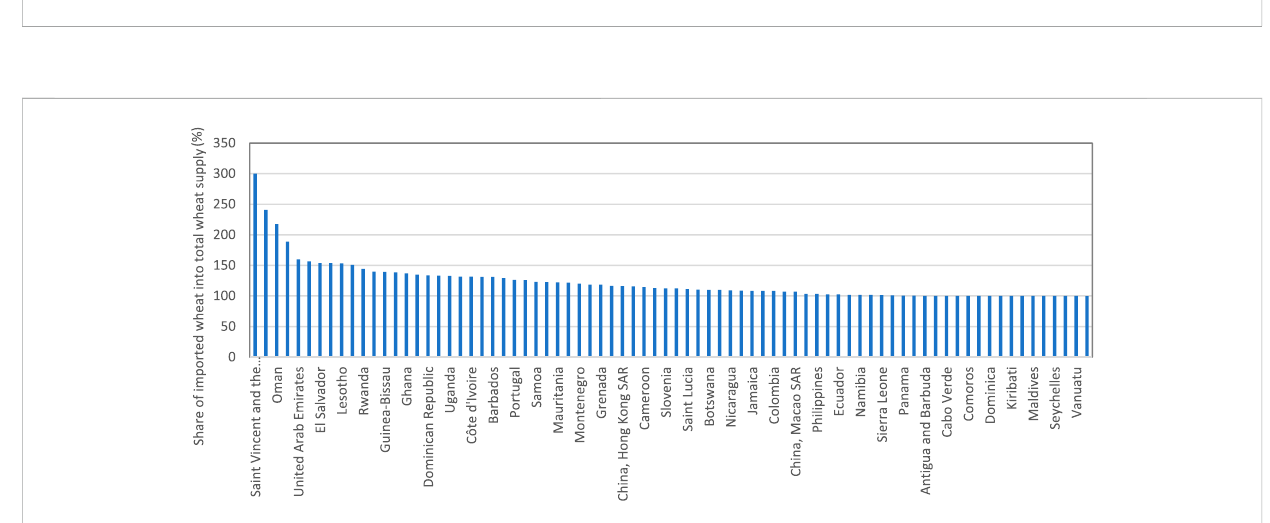
Listofcountriesin2019,wherewheatconsumptioncompletelyreliesonimportedwheat(importedwheat/Total domesticsupply)( ≥ 100%).Source: Authors based on FAOSTAT